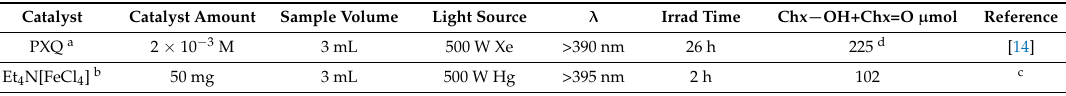
Table 9. Comparison of homogeneously and heterogeneously catalyzed photooxidation of cyclohexane.